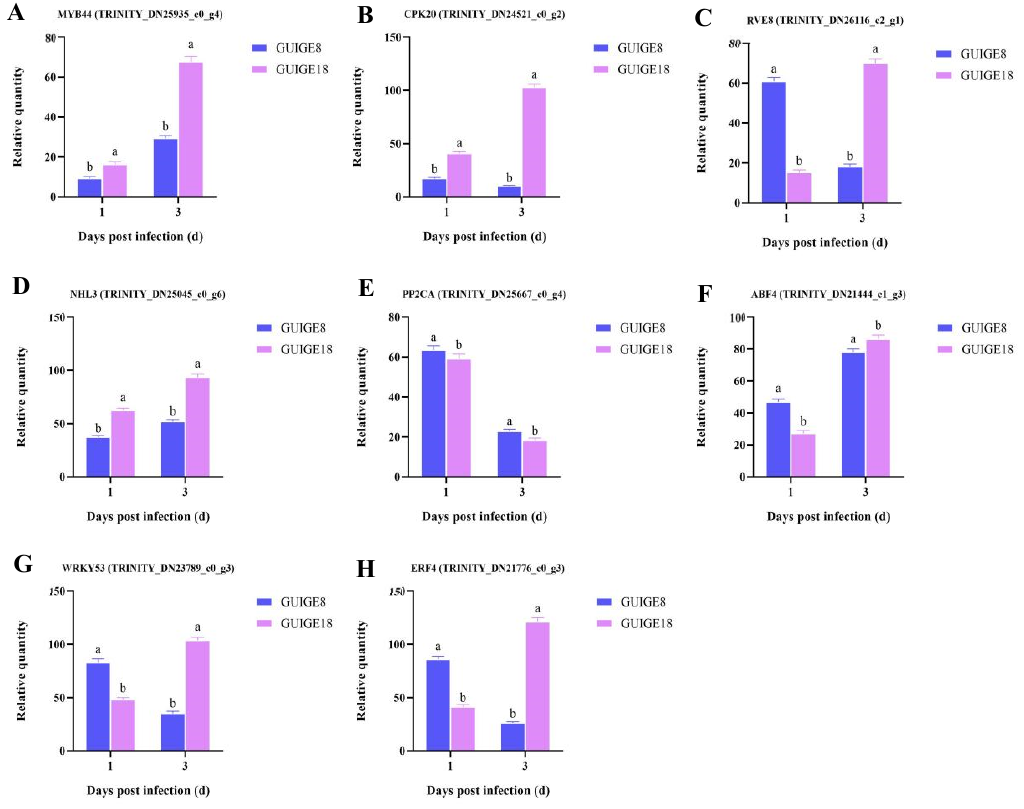
Figure 9. The expression of DEGs related to plant hormone signal transduction. ( A ) MYB44; ( B ) CPK20; ( C ) RVE8; ( D ) NHL3; ( E ) PP2CA; ( F ) ABF4; ( G ) WRKY53; and ( H ) ERF4. The Y axis shows the relative quantity means of three independent replicates, calculated using the 2 − △△ Ct method. Letters ‘a/b’ indicate difference changes between the two cultivars on the same day ( p < 0.05), according to Duncan’s multiple range test using SPSS software.